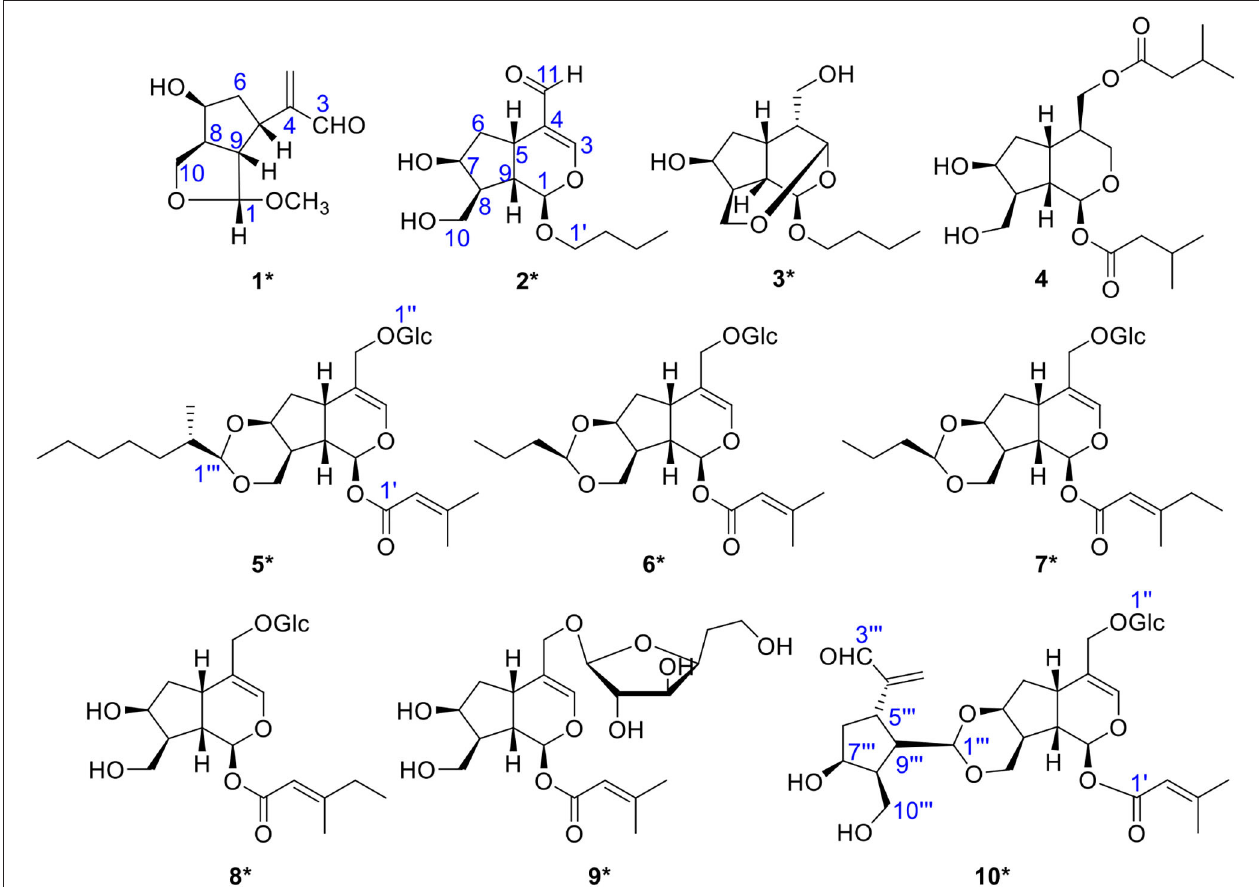
FIGURE 1 | The chemical structures of compounds 1 - 10 (*new